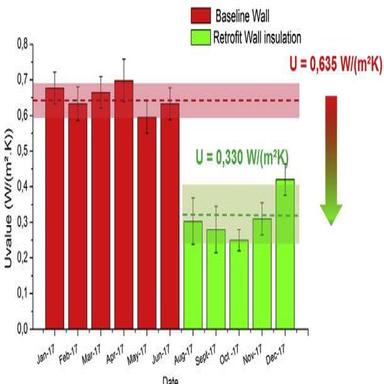
Thermal transmittance coefficient of the test wall monthly averaged.